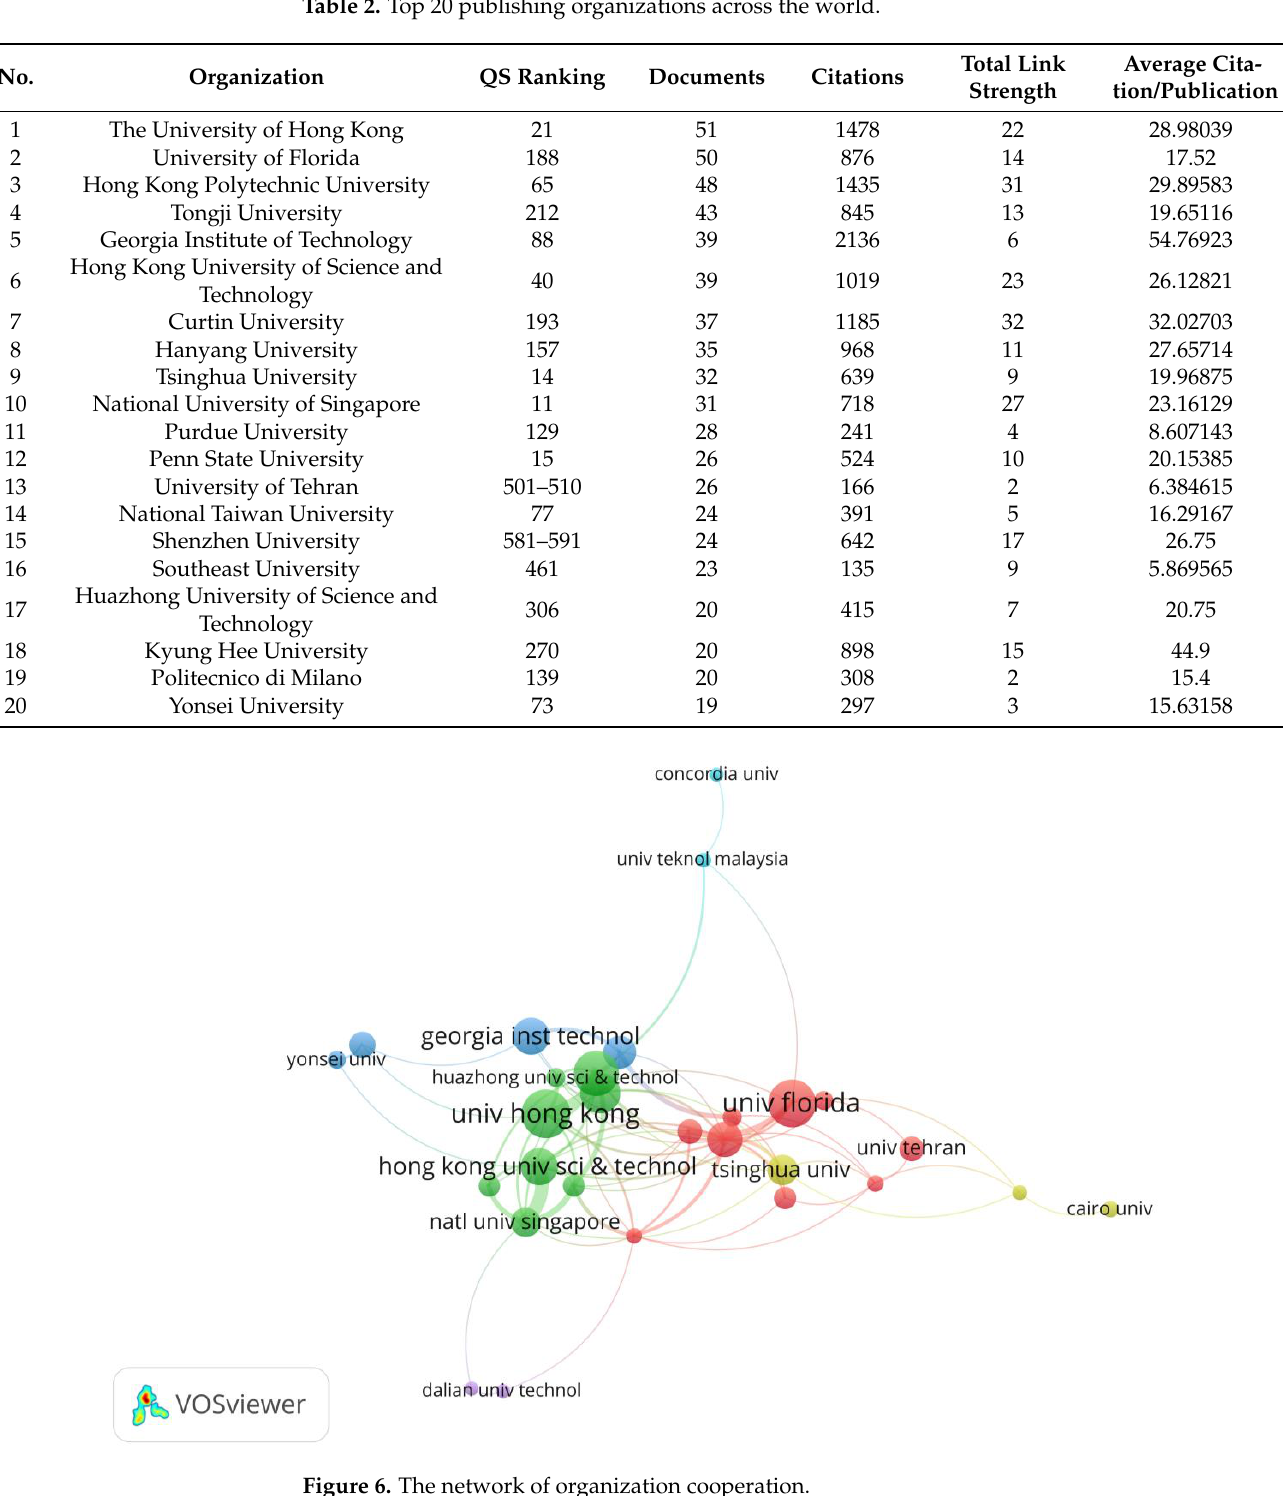
Figure 6. The network of organization cooperation.